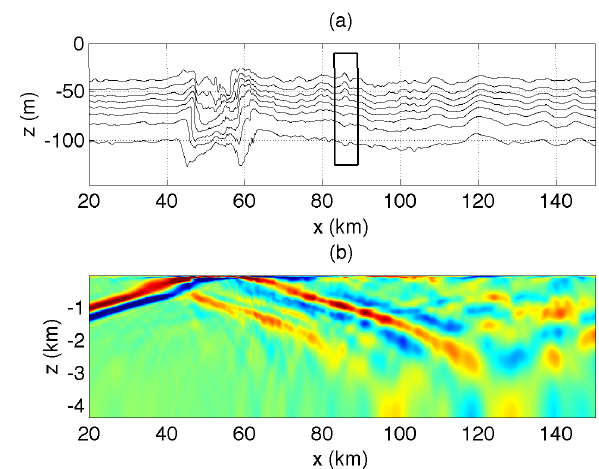
Fig. 2. Snapshot taken from E1, 16 M2 periods after the start of the simulation. (a) : Contours of a few isopycnals around the thermo- cline. A mode-2 ISW is framed. (b) : Horizontal velocity field in the domain, the colour scale ranging from − 12 (blue) to + 12 cm . s − 1 (red). Note that x ≥ 20km and that, therefore, the forcing beam at the western boundary has already been refracted by the varying N(z) profile.